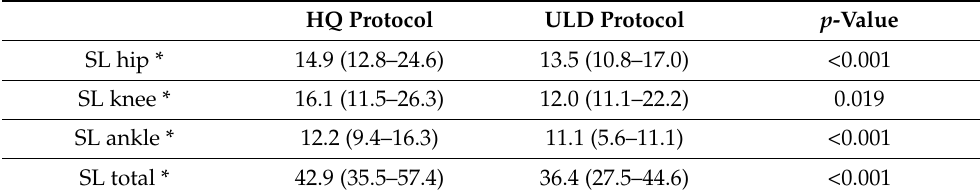
Table 5. Scan length of the HQ protocol and the new ULD protocol in CT-torsion